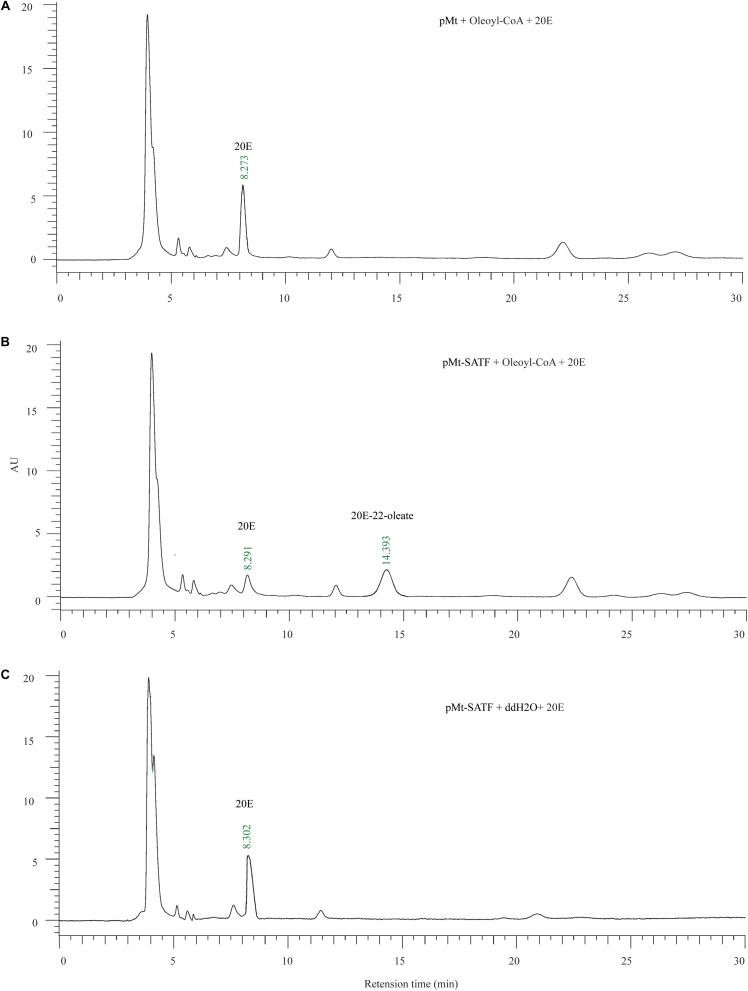
Enzymic activity of recombinant Sterol O-acyltransferase, SATF proteins. (A) The enzyme assay of the supernatant of the control vector (pMt) infected cell with the 20E and Oleoyl-CoA. (B) The enzyme assay of the supernatant of the pMt-SATF infected cell with the 20E and Oleoyl-CoA. (C) The enzyme assay of the supernatant of the pMt-SATF infected cell with the 20E and water.